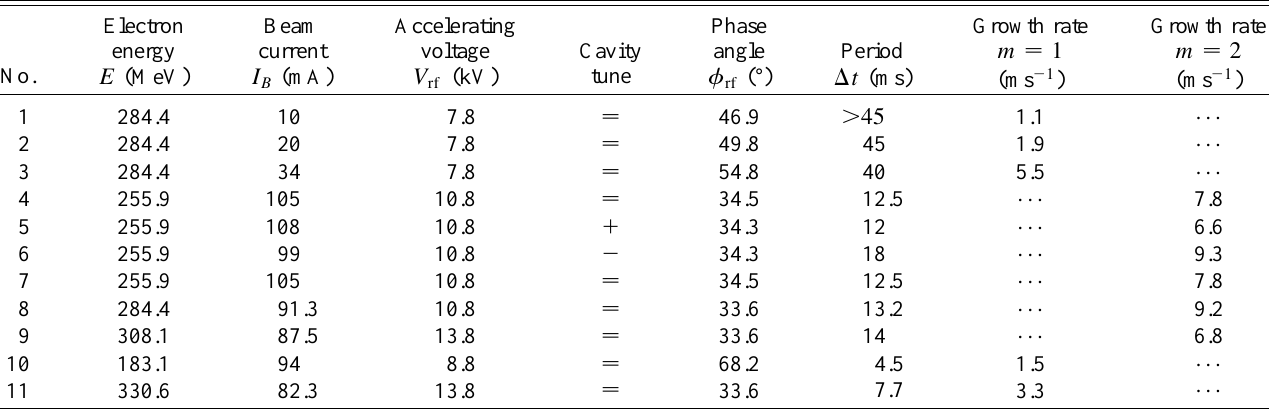
TABLE II. Period of the sawtooth instability and growth rate of the dominant coherent bunch phase oscillation modes ( m (cid:1) 1, 2 ) as a function of electron energy, beam current, cavity tune (relative to revolution harmonic: (cid:1) on resonance, 1 above harmonic, 2 below harmonic), and rf transmission line phase angle. In data sets 1–3, only the current is varied (phase angle adjusted for maximum growth). In data sets 4–6, the cavity tune is varied. In data sets 7–11, the growth rates of the dominant modes are given for different machine